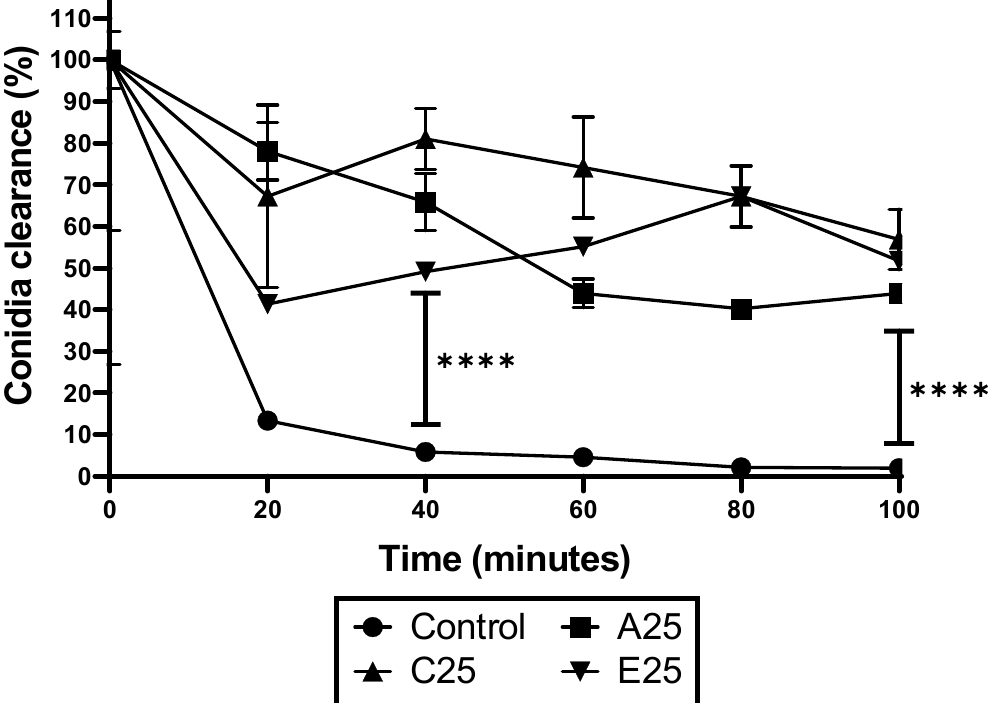
Figure 2. Response of A. fumigatus conidia to hemocyte-mediated killing. The conidia of A. fumigatus passaged and control strains were exposed to G. mellonella hemocytes ex vivo. The passaged strains demonstrated significantly increased tolerance to immune cell killing at 40 min (**** p < 0.0001) and 100 min (**** p < 0.0001), determined by a one-way ANOVA followed by pair-wise multiple comparisons using the Tukey test.